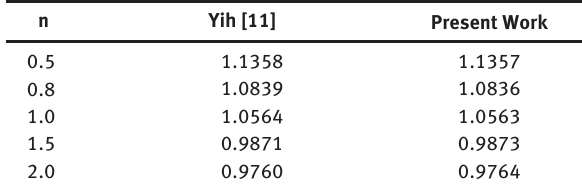
Table 1: Comparison of θ (0, 0) for vertical cone with S r = 0, ϵ = 0, Gr * = 0 and N = 0 .